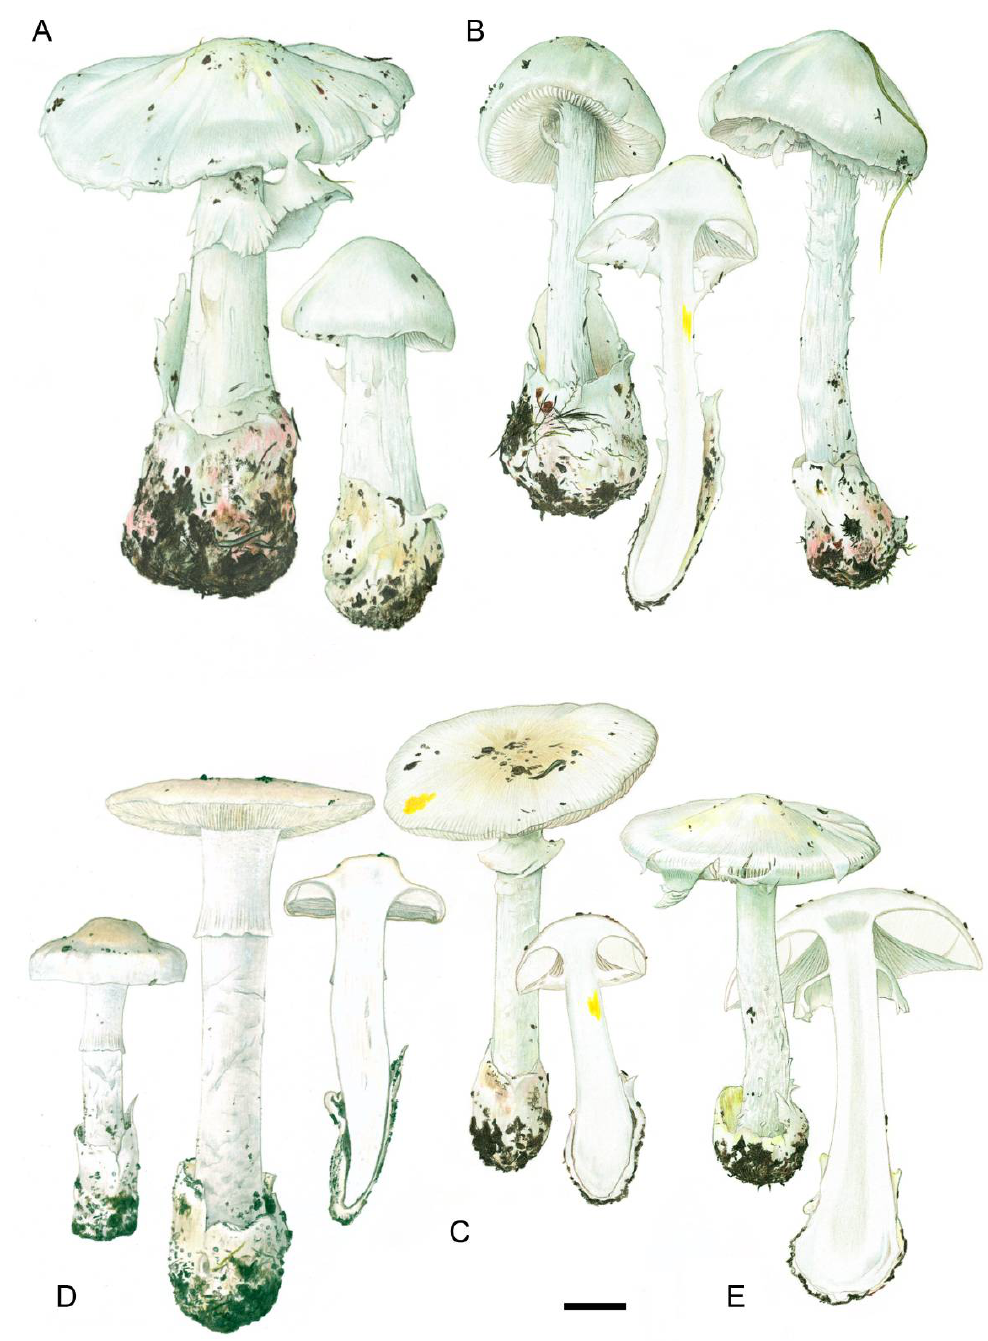
Figure 3. Drawings of basidiomes in Reumaux & Carteret (2013). ( A ) Amanita amerivirosa . ( B ) Amanita virosa . ( C ) Amanita verna . ( D ) Amanita vidua . ( E ) Amanita phalloides var. alba . Reproduced with permission of the authors and the editor from Patrick Reumaux and Xavier Carteret, Les Tueurs, published by Klincksieck editions, Paris, 2013 (except D, original drawing by X. Carteret). Bar = 1 cm.